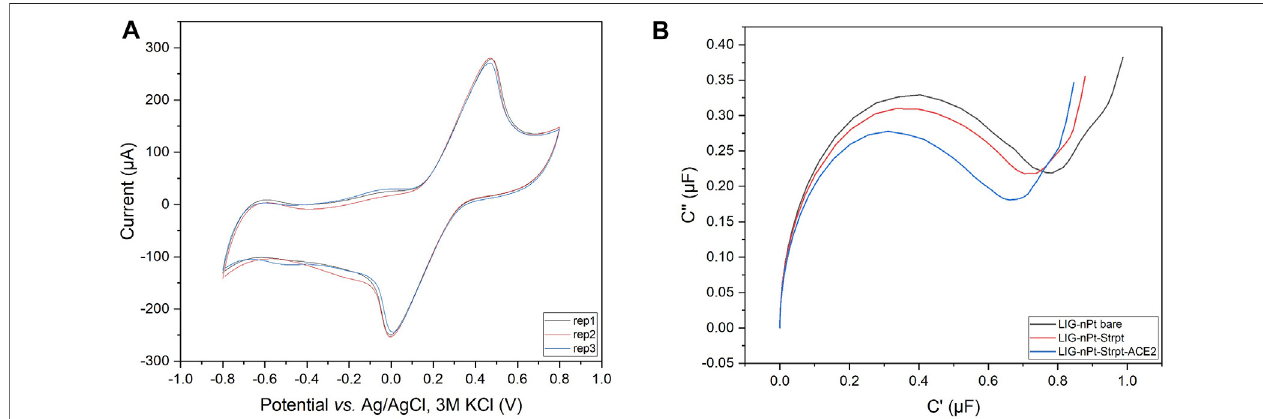
FIGURE 3 | Replicate selection and biofunctionalization. (A) Representative cyclic voltammogram of the LIG-nPt electrode replicates vs. Ag/AgCl (3M KCl) in 100 mM KCl and 2.5 mM K 3 [Fe(CN) 6 ]/K 4 [Fe(CN) 6 ] at scan rates of 200 mV s − 1 . (B) Representative Nyquist capacitive plot (C ′ vs. C ″ ) of biofunctionalization with truncated hACE2 biotin-tag immobilized on the working electrode via the streptavidin – biotin coupling method.